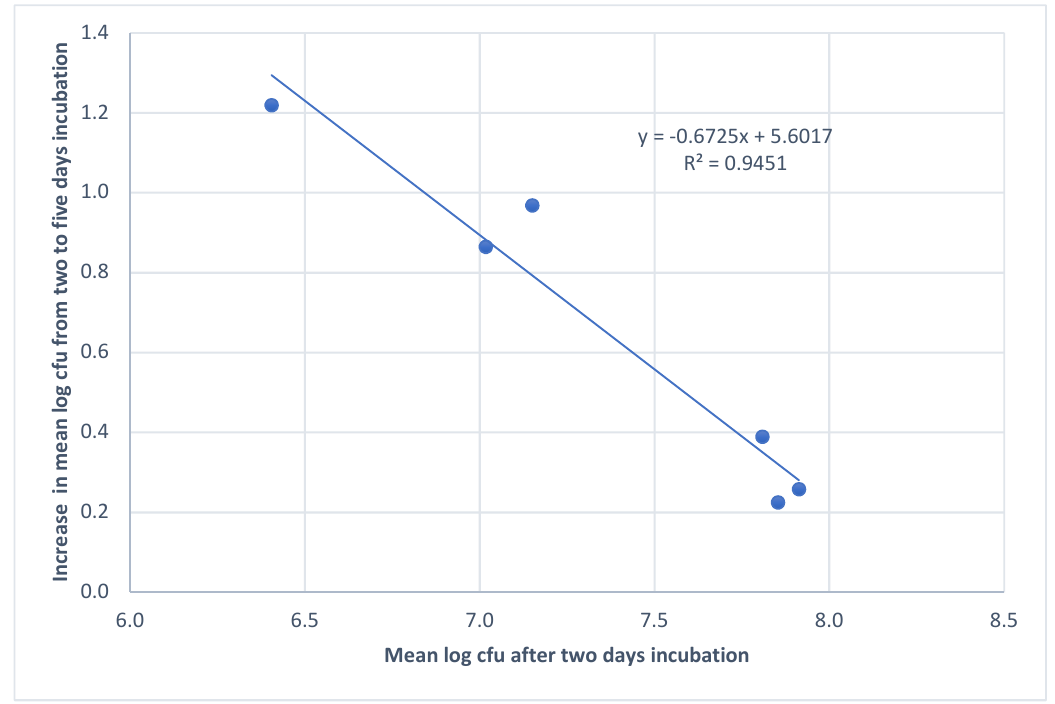
Figure 1. Correlation between mean log 10 CFU in the biofilm after two days incubation and the increase in mean log 10 CFU from two to five days.